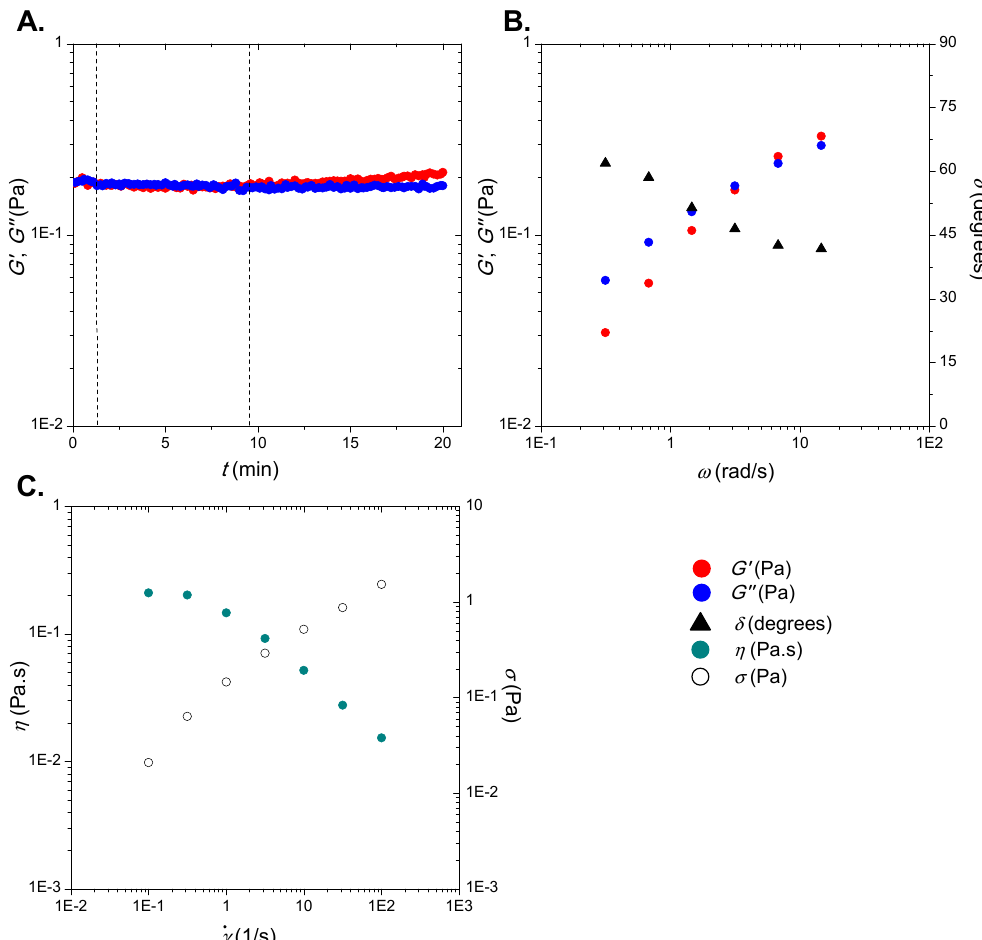
Figure 3. Representative rheological analysis of equine synovial fluid from an osteoarthritic fetlock joint: time sweep ( A ), frequency sweep ( B ), and flow step ( C ) all at 37.5 °C; all graphs were obtained from samples from the same joint.